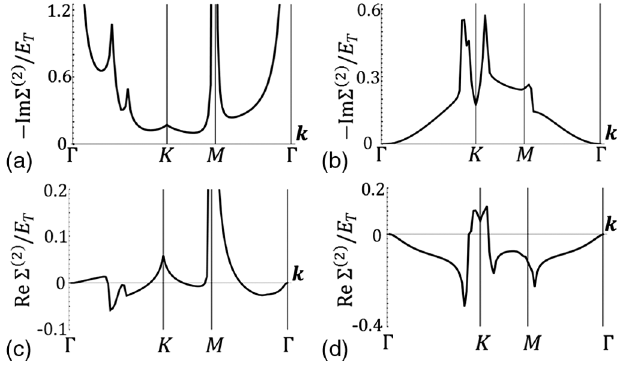
FIG. 2. Normalized decay rate of the (a) up-band and (b) down- band. A sequence of van-Hove-like peaks is a unique signature of the Dirac dispersion. Normalized magnon dispersion renormal- ization for (c) up-band and (d) down-band. The vertical axes are plotted with respect to the temperature-dependent energy unit E T 2 =JS 3 ; therefore, all contributions scale with temperature T ¼ as T 2